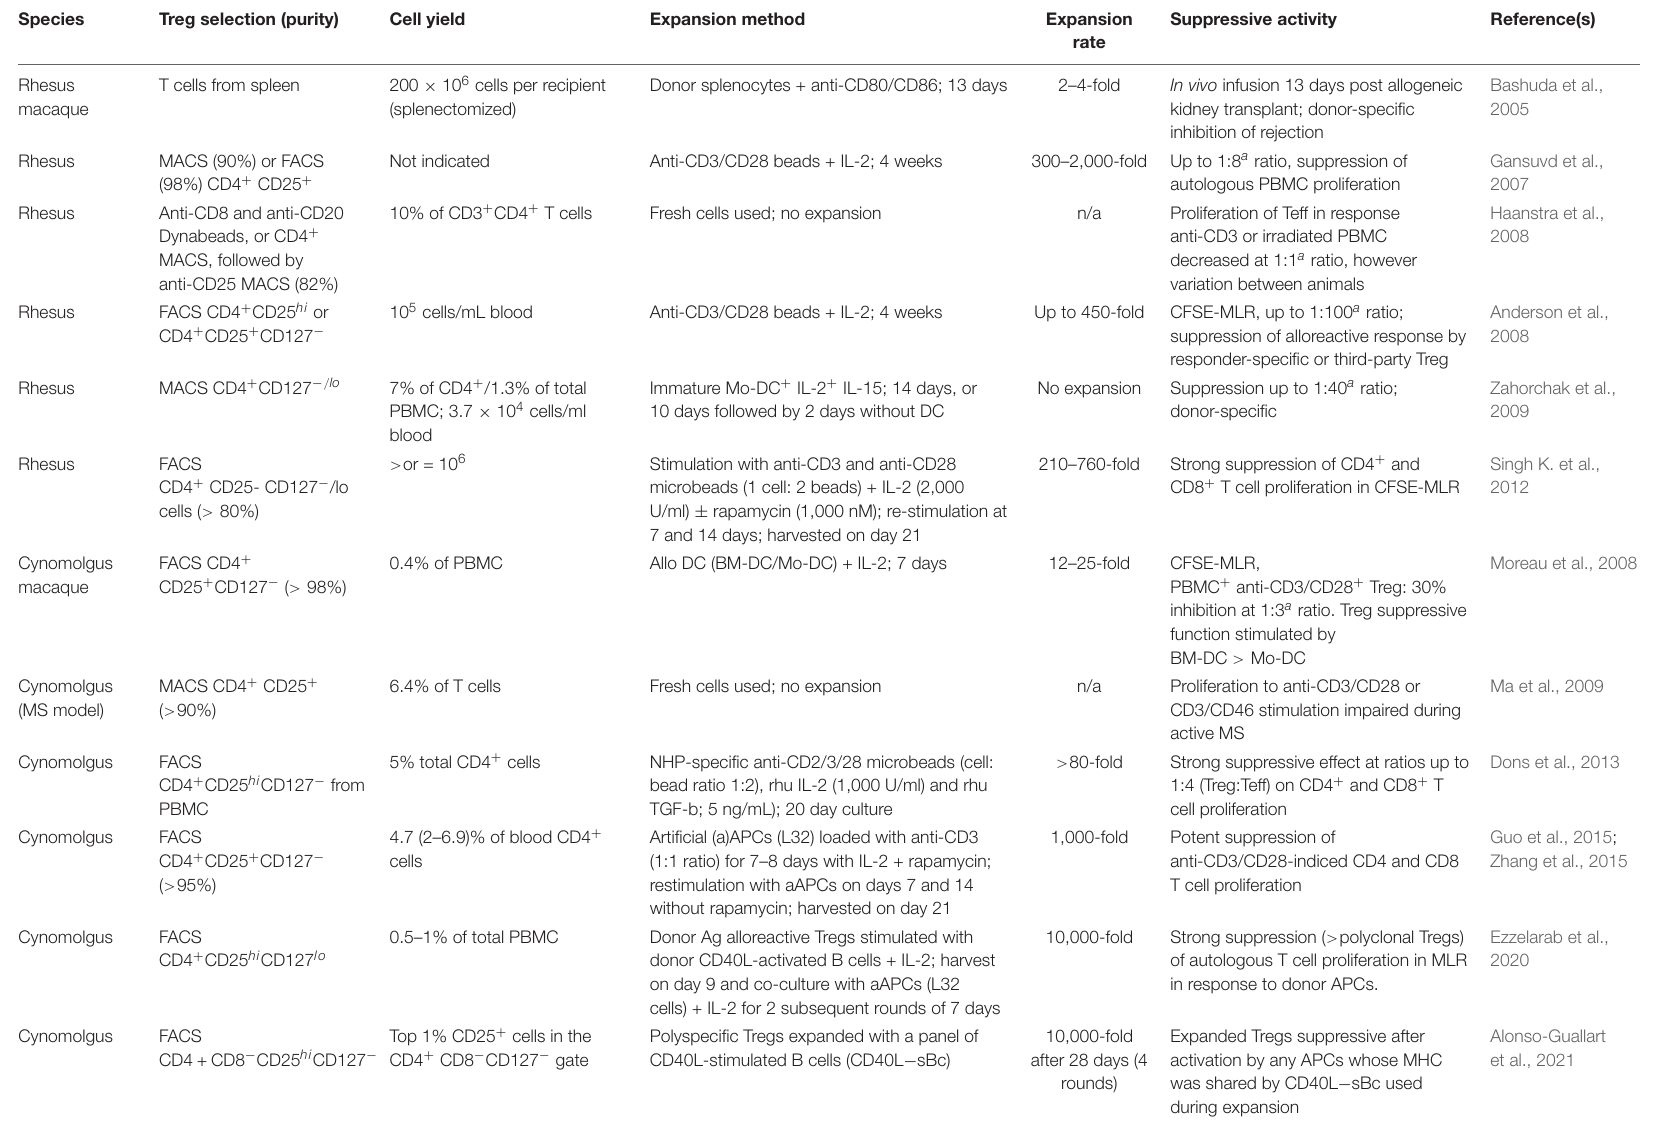
TABLE 1 | Timeline of reports of Treg isolation, expansion and suppressive activity in NHP